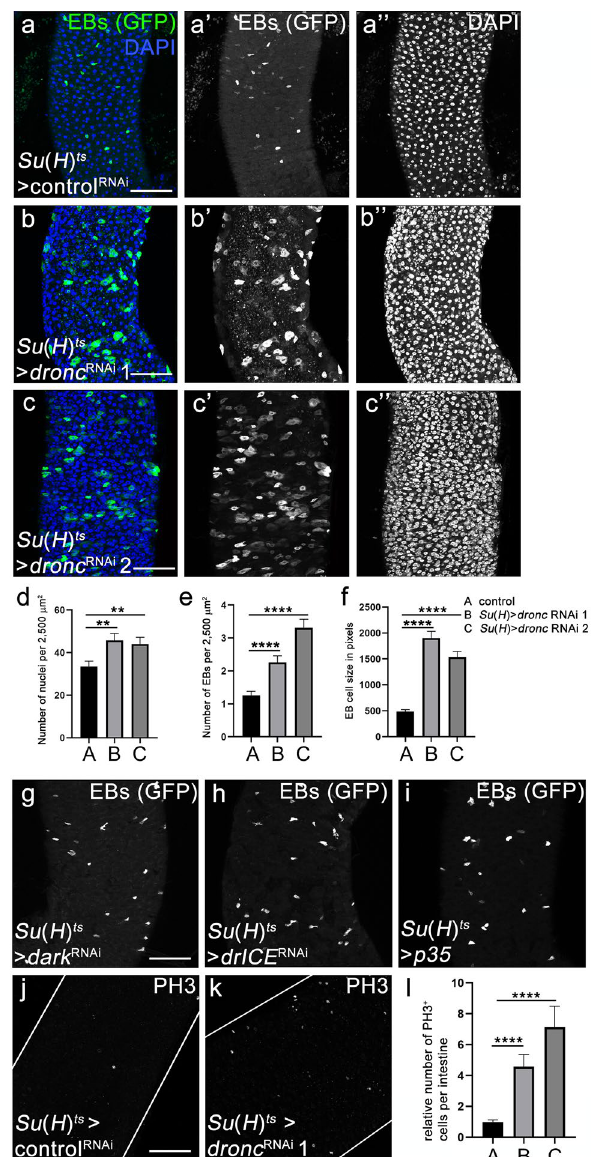
Figure 3. EB-specific knockdown of dronc causes accumulation of EBs and hyperplasia. In this and the following figure, crosses were raised at 18 °C until adults eclosed. 5 days old females of the indicated genotype were shifted to 29 °C and incubated for 5–6 days until dissection and labelling of the midguts. Two different dronc RNAi transgenes were used: line 1 = P{GD12376}v23033; line 2 = P{KK104278}v100424. Luciferase RNAi was used as a control in ( a ). ( a – c ) Control ( a ) and Su ( H ) ts > dronc RNAi 1 and 2 ( b , c ) midguts were labelled with GFP (green in a – c ; grey in a’ – c’ ) and DAPI (blue in a-c; grey in a’’ – c’’ ). Note that in addition to an increased number of EBs in response to dronc RNAi, these cells also underwent morphological changes and appear much larger compared to control ( a ). Scale bar: 50 µm. Complete genotypes: ( a ) Su(H)-Gal4 UAS-GFP tub-Gal80 ts ; UAS-luciferase RNAi; ( b ) Su(H)- Gal4 UAS-GFP tub-Gal80 ts ; UAS-dronc RNAi 1; ( c ) Su(H)-Gal4 UAS-GFP tub-Gal80 ts ; UAS-dronc RNAi 2. ( d , e ) Quantification of the numbers of nuclei (DAPI) and EBs (GFP) of the genotypes in ( a – c ). To obtain DAPI counts, at least five random, but representative fields of 2500 μm 2 each per posterior midgut were counted. In the case of EBs, all GFP-positive cells (corresponding to EBs) were counted in region R4ab and normalized to 2500 μm 2 fields. Data were analyzed by one-way ANOVA with Holm-Sidak test for multiple comparisons. Error bars are SEM. ****p < 0.0001; **p < 0.01. Number of midguts analysed: n = 12 (control), 9 ( dronc RNAi 1), 12 ( dronc RNAi 2). ( f ) Quantification of the cell size of EBs of control and dronc RNAi midguts. Shape of EBs was outlined using the quick selection tool in Photoshop and the number of pixels in the selected area was recorded. Data were analyzed by one-way ANOVA with Holm-Sidak test for multiple comparisons. Error bars are SEM. ****p < 0.0001. n = 24 (control), 25 ( dronc RNAi 1), 24 ( dronc RNAi 2). ( g – i ) EB-specific knockdown of dark ( g ) and drICE ( h ) by RNAi or overexpression of p35 ( i ) does not phenocopy the phenotypes observed by dronc RNAi (compare to ( b , c )). More examples and quantifications are shown in Supplementary Fig. S2. EBs were labelled with GFP. The conditions were the same as in ( a – c ). Scale bars: 50 µm. Complete genotypes: ( g ) Su(H)-Gal4 UAS-GFP tub-Gal80 ts ; UAS-dark RNAi; ( h ) Su(H)-Gal4 UAS-GFP tub-Gal80 ts ; UAS-drICE RNAi; ( i ) Su(H)-Gal4 UAS-GFP tub-Gal80 ts ; UAS-p35 . ( j , k ) PH3 labelings of control and Su ( H ) ts > dronc RNAi midguts. Scale bar: 50 µm. Complete genotypes: ( j ) Su(H)-Gal4 UAS-GFP tub-Gal80 ts ; UAS-luciferase RNAi; ( k ) Su(H)-Gal4 UAS-GFP tub-Gal80 ts ; UAS-dronc RNAi (P{GD12376}v23033). ( l ) Quantification of PH3 labelings of control and Su ( H ) ts > dronc RNAi midguts. PH3 cells were manually counted across the entire intestine and analysed by one-way ANOVA with Holm-Sidak test for multiple comparisons. Error bars are SEM. ****p < 0.0001. n = 10 (control), 11 ( dronc RNAi 1), 10 ( dronc RNAi 2). Genotypes as in ( a–c ). See also Supplementary Figs. S2 and